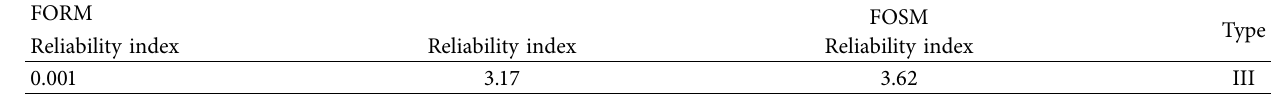
Table 6: Results of reliability analysis of three-story steel frame with RT program. FORM